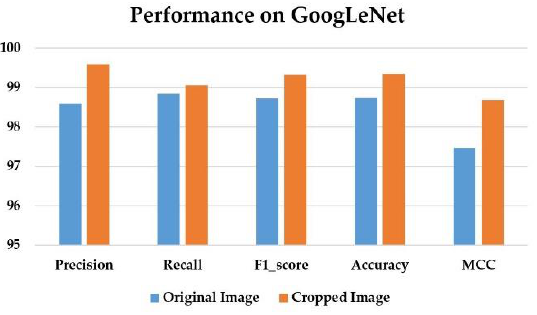
Figure 17. Performance comparison of two datasets on GoogLeNet.